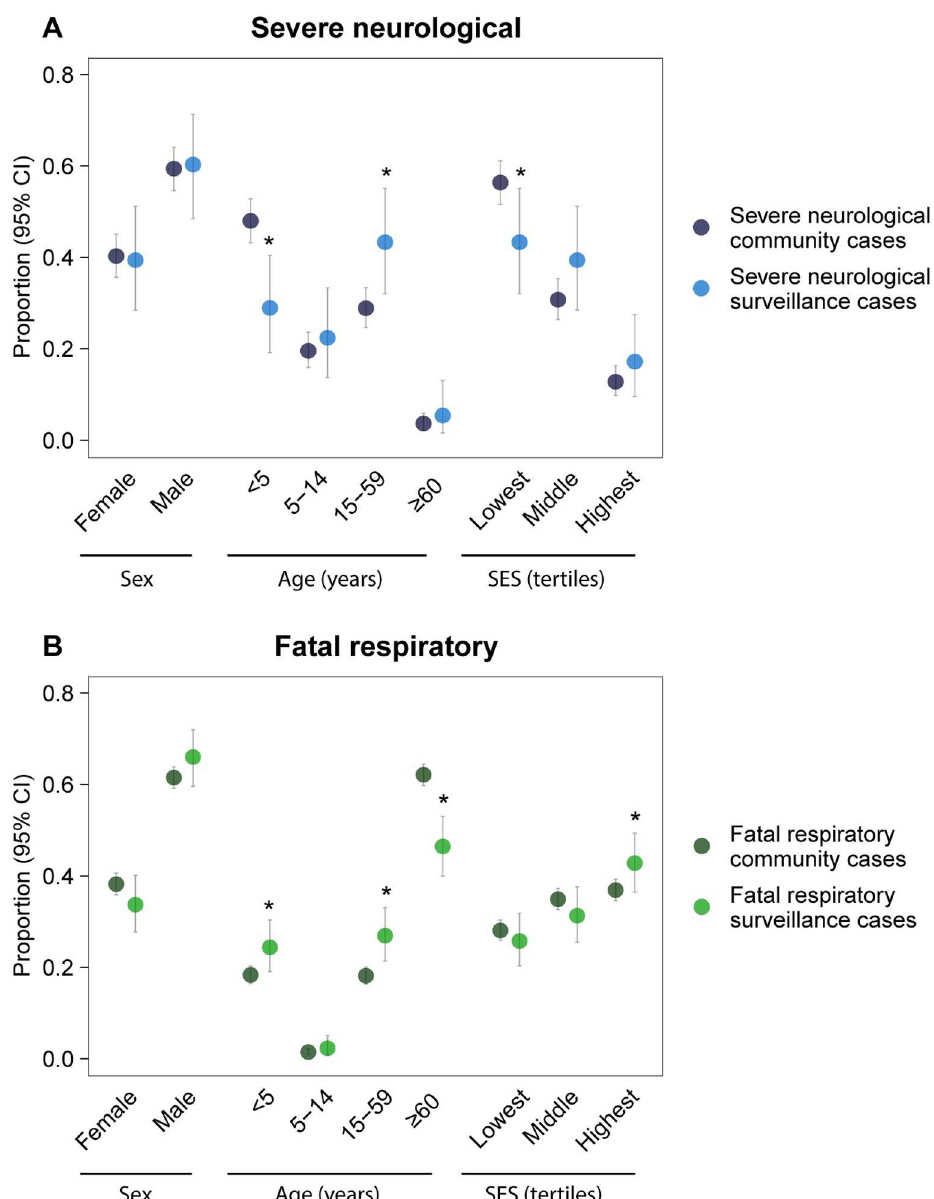
Fig 4. Representativenessof surveillance cases. Comparison of case statistics (proportion of cases with a characteristic) estimated for community cases to those estimated for surveillance cases for (A) severe neurological infectiousdisease and (B) fatal respiratoryinfectiousdisease.Significantdifferences (bootstrap p (cid:20) 0.05) are indicatedwith an asterisk. SES, socioeconomic status.